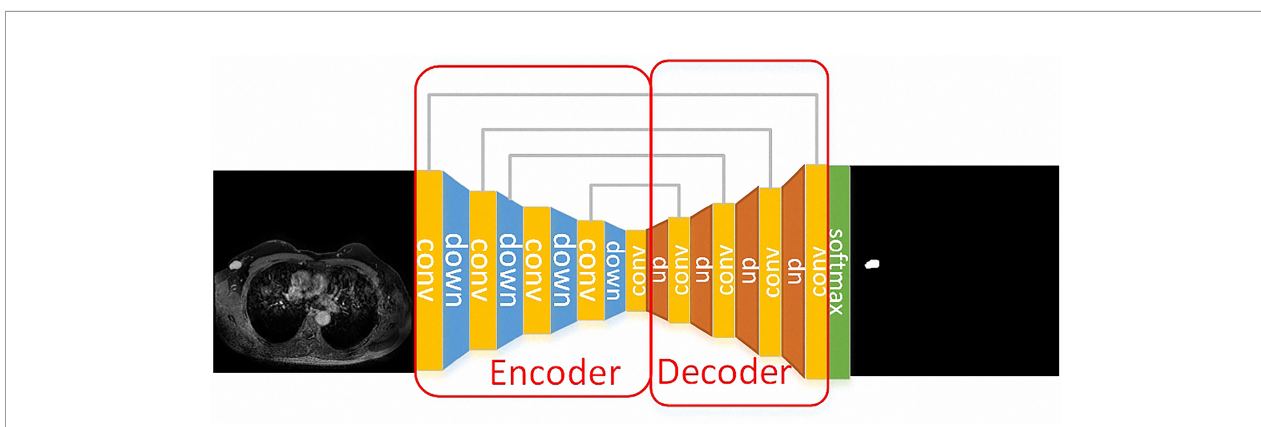
FIGURE 1 | A case for the segmentation process. The Unet model was used for the segmentation of the breast tumors. The down-sample layer is the blue module in the fi gure, which is realized by max-pooling. The up-sample layer is the red module in the fi gure, which is realized by deconvolution. Moreover, skip connection is represented by a gray line, which combines low-level features and high-level semantic features to realize up-sampling step by step. Finally, the feature map is converted into the probability graph through softmax operation.